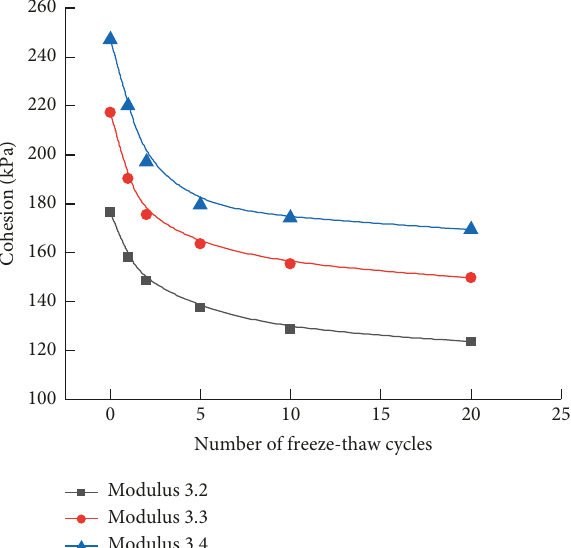
Figure 4: Cohesion changes with the number of freeze-thaw cycles.